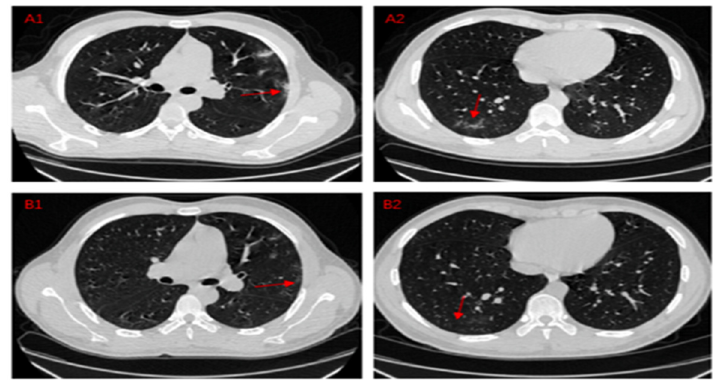
Figure 3. CT scan image of a COVID-19 pneumonia patient [36].